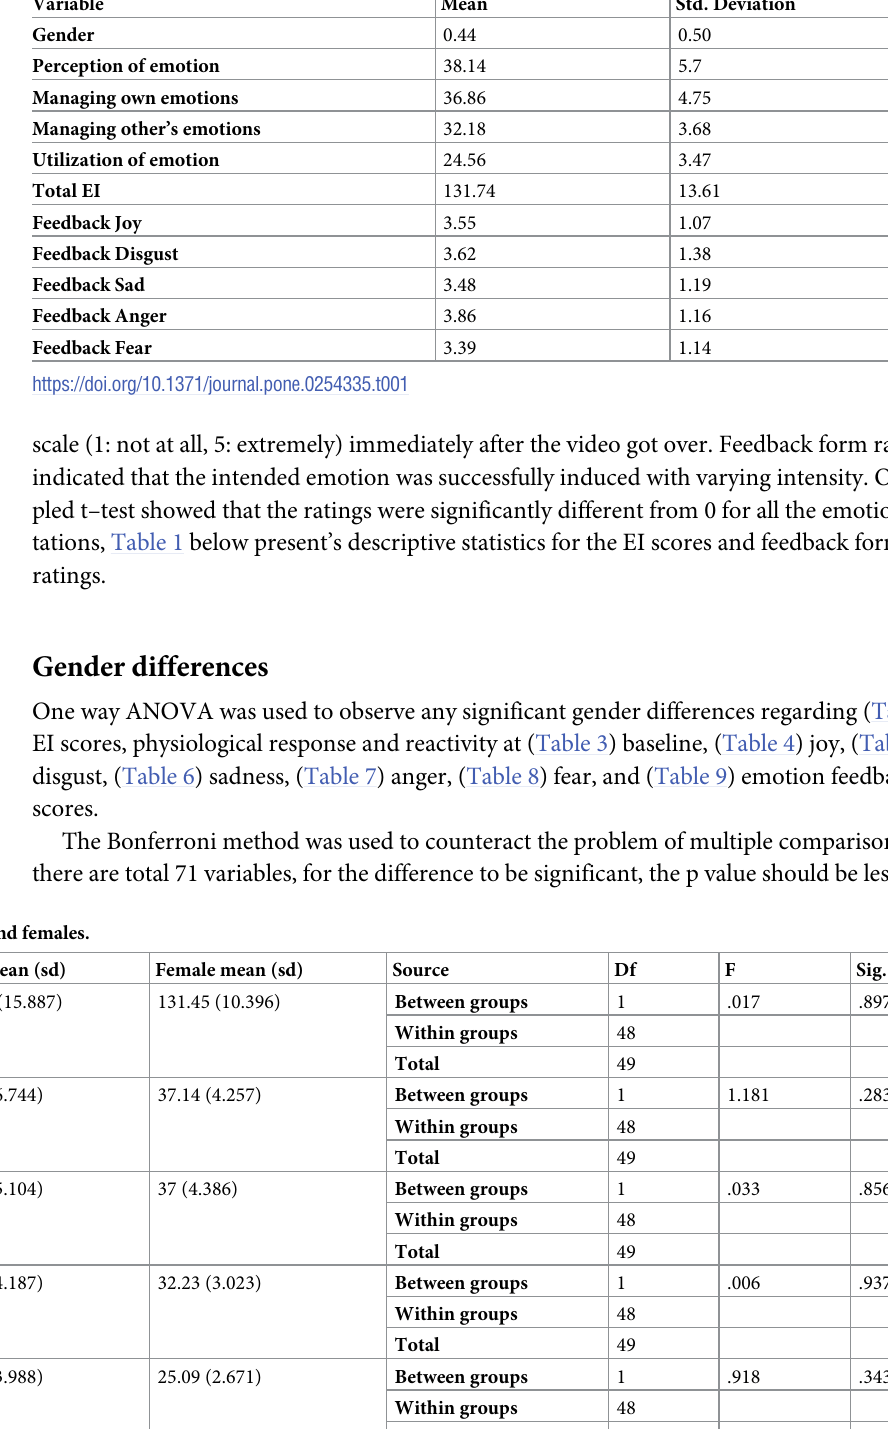
Table 1. Descriptive statistics for SSEIT scores and feedback form rating.